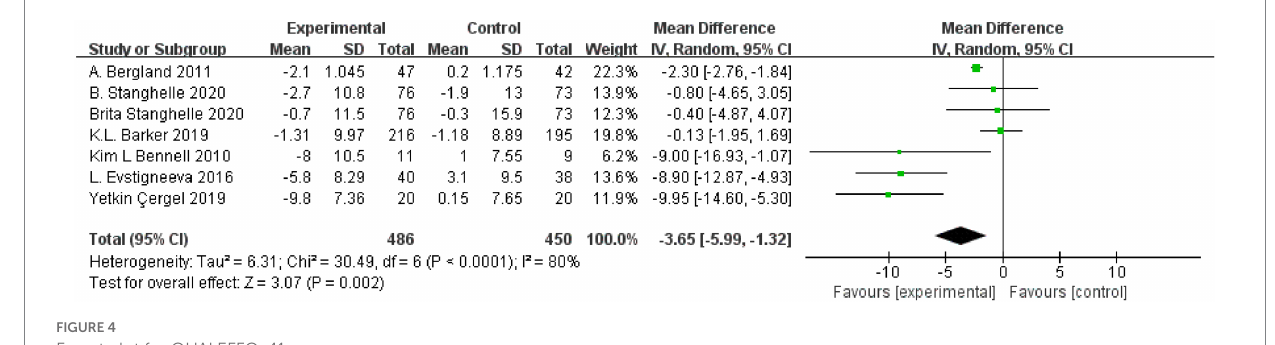
FIGURE 4 Forest plot for QUALEFFO-41 scores.